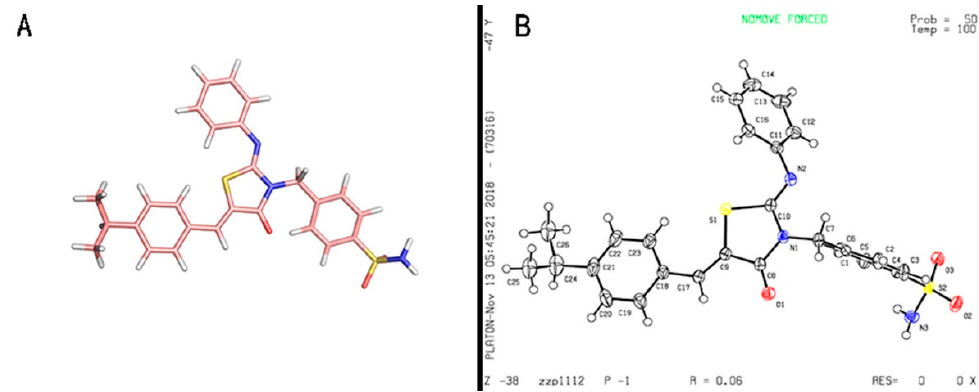
Figure 5. The molecular structure ( A ) and single-crystal structure ( B ) of compound ( 13 ) .